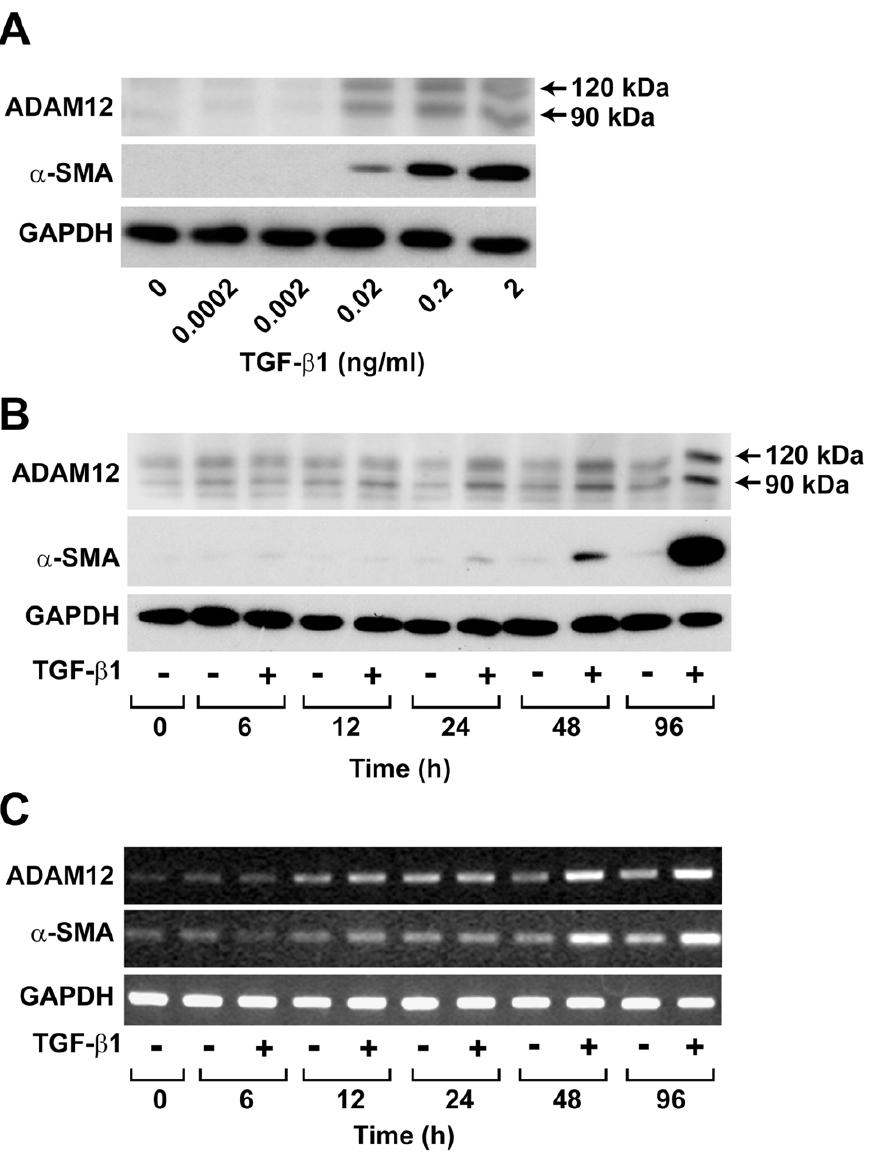
Figure 2. Effects of TGF- b 1 on the expression of ADAM12 and a -SMA in hASCs. (A) Dose-dependent effects of TGF- b 1 on the expression of ADAM12 and a -SMA. hASCs were treated with the indicated concentrations of TGF- b 1 for 4 days. (B) Time dependence of TGF- b 1-induced expression of ADAM12 and a -SMA. hASCs were treated with serum-free medium containing 1 ng/mL TGF- b 1 or vehicle (0.1% BSA) for the indicated time periods. The expression levels of a -SMA, ADAM12, and GAPDH were determined by Western blotting. The ADAM12 protein bands with molecular masses of , 120 kDa and , 90 kDa are indicated. (C) TGF- b 1-induced mRNA expression of ADAM12 and a -SMA. hASCs were treated with serum-free medium containing 1 ng/mL TGF- b 1 or vehicle (0.1% BSA) for the indicated time periods. The expression levels of a -SMA, ADAM12, and GAPDH were determined by RT-PCR analysis. Representative data from three independent experiments are shown.